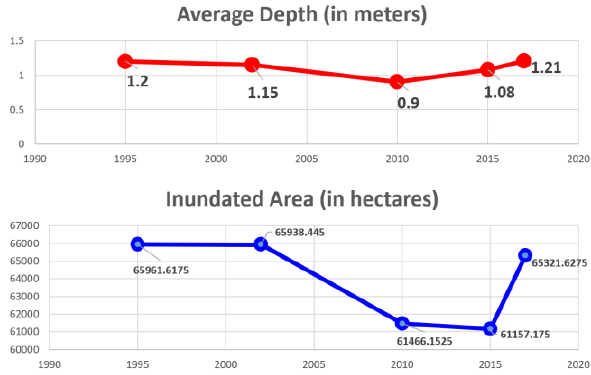
Figure 10. Summary of 2D flood modelling simulation result for the Agusan Marsh under different years/land-cover